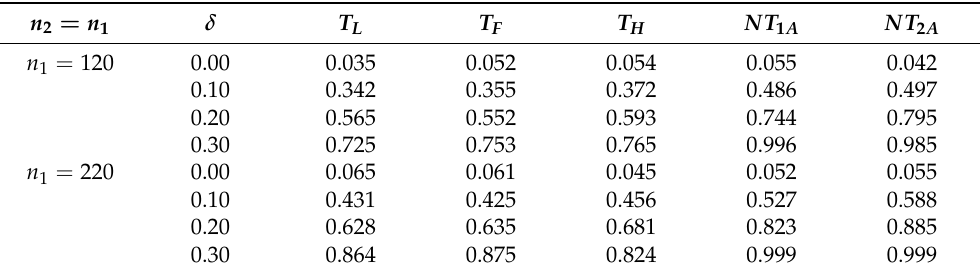
Table 3. Size and power of five methods in Setting 3 (mean difference lies in latter part µ 2 [ 21 : 26 ] = µ 1 [ 21 : 26 ] + δ ).